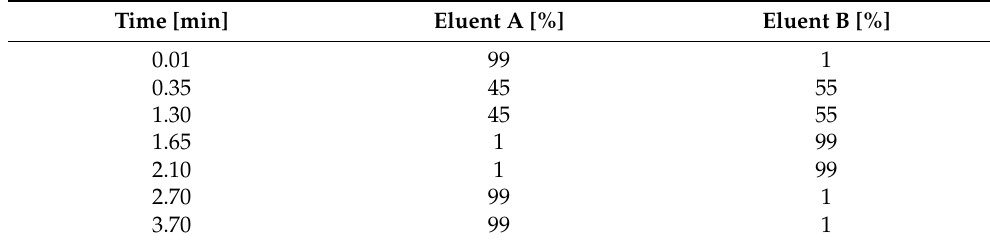
Table A1. Gradient elution for quantification of meropenem and piperacillin.